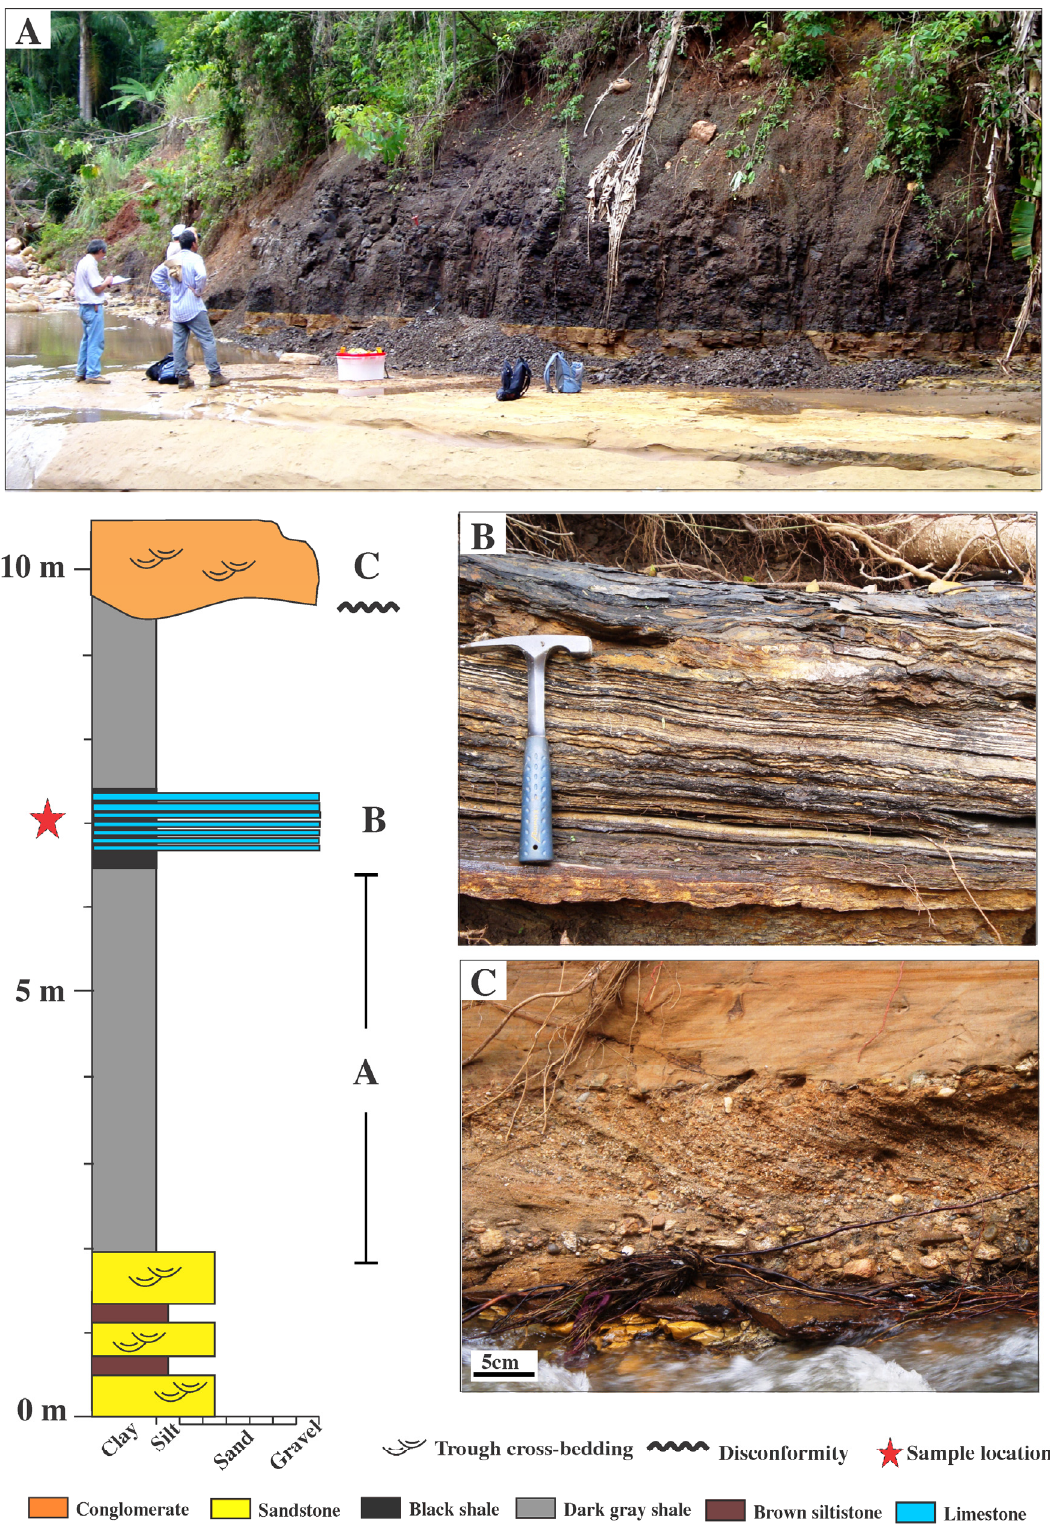
Figure 4. “Batateira Beds” in the Rio de Batateira section. ( A ) Contact between dark shales from the Batateira layers and the underlying fluvial sandstones of the Barbalha Formation (riverbed); ( B ) organic-rich dark shales interbedded with thin limestone laminae; ( C ) basal conglomerate and cross-bedded sandstones overlying shales (based on Assine et al. [34]).